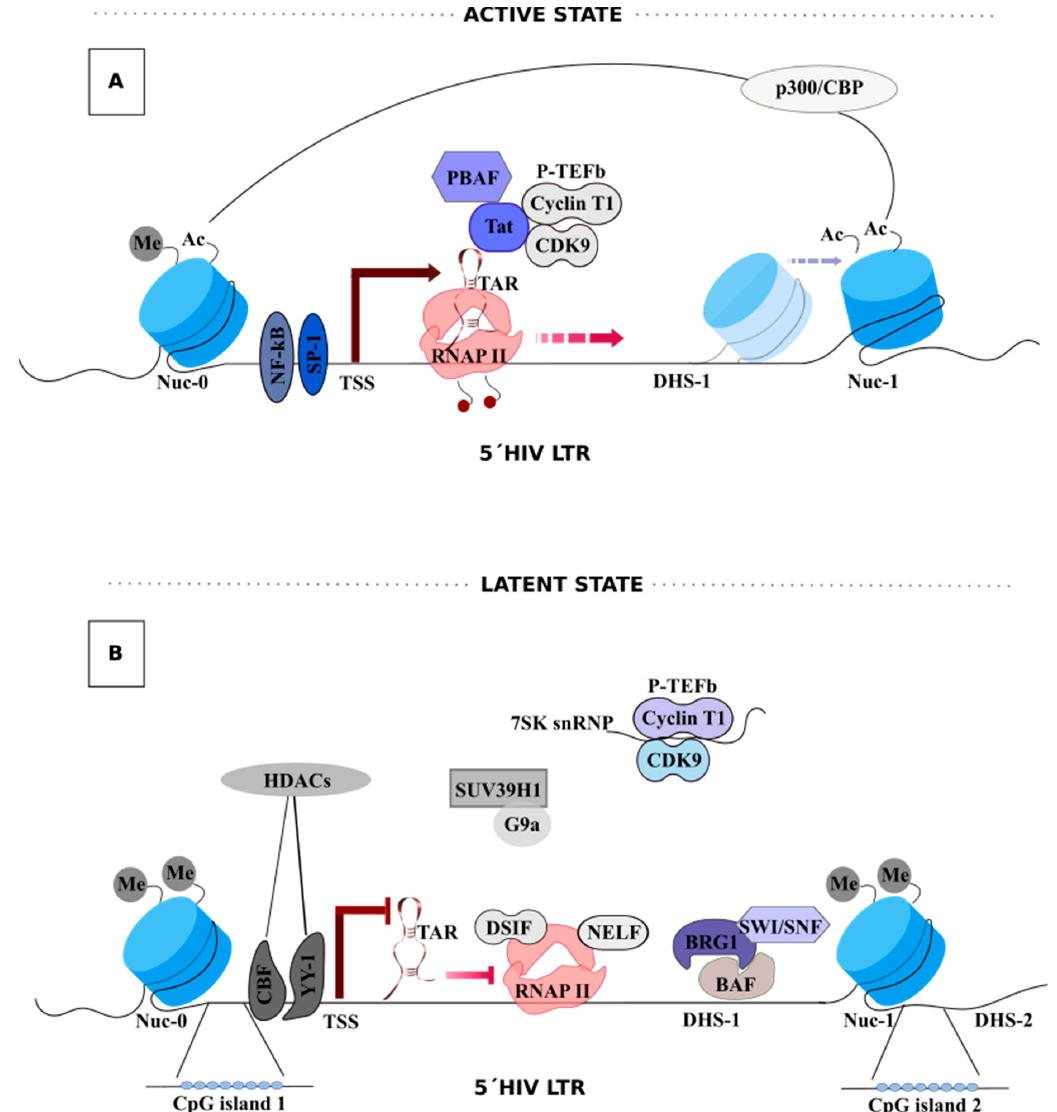
Figure 1. Regulation of HIV transcription. ( A ) Tat-mediated HIV-1 transcription. The transition from transcriptional initiation to elongation implies the replacement of transcriptional repressors by activators, including NF- κ B, SP-1, and histone acetyltransferases (HATs), such as p300 / CREB-binding protein (CBP). HATs promote open chromatin and recruitment of polybromo-associated factor (PBAF). PBAF repositions Nuc-1 further downstream of the transcription start site (TSS), enabling e ffi cient transcriptional elongation. Furthermore, the secondary structure of the nascent TAR RNA is also accessible for the biding of Tat protein and further transcription activation. P-TEFb-associated CDK9 phosphorylates the CTD of RNAPII at serine 2, enabling the production of full-length HIV-1 transcripts, which are spliced to produced Tat and an active transcription elongation is established. A Tat-dependent positive feedback loop is generated by increasing HIV-1 transcription and, consequently, exponential replication. ( B ) Establishment of HIV-1 latency. Several proteins are implicated in the establishment of HIV-1 latency. These include transcription factors such as YY-1 and CBF, enabling the recruitment of histone deacetylases (HDACs). HDACs remove acetyl groups from core histones, namely, at Nuc-1, restricting the accessibility of positive transcription factors to the promoter, promoting viral latency. Histone methyltransferases (HMTs) involved in the establishment of HIV-1 latency include SUV39H1 and G9a, which are involved in Lys9 trimethylation of histone H3 (H3K9me3) and H3K9 dimethylation (H3K9me2), respectively. Two factors, DSIF and NELF, co-operate to pause